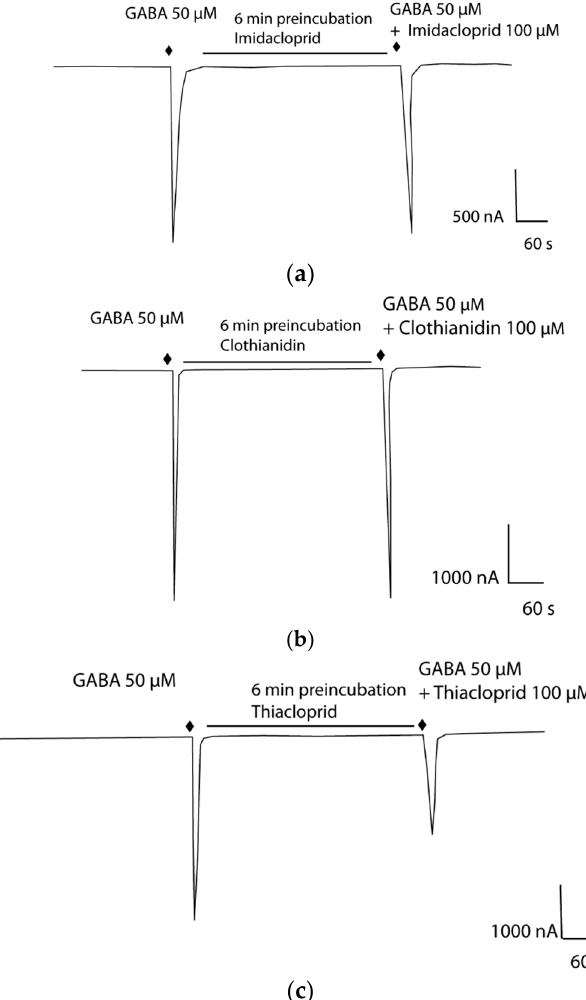
Figure 7. Representative current traces showing effects of 100 μ M ( a ) imidacloprid, ( b ) clothianidin and ( c ) thiacloprid on GABA-induced currents (at EC 50 concentration) in X. laevis expressing Apisum RDL1 bd .